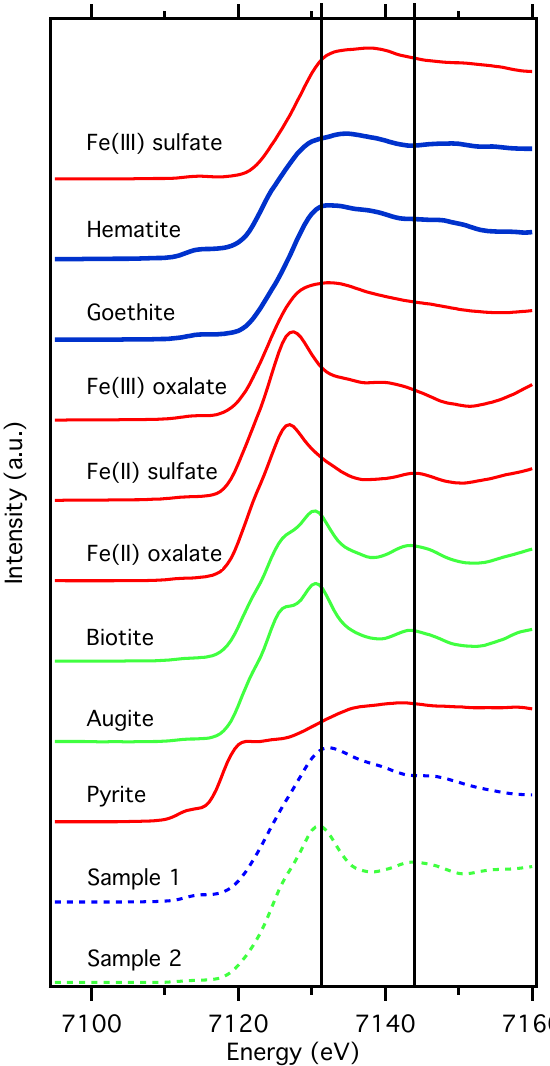
Fig. 4. Comparison of XANES sample spectra (dashed line) to the spectra of common Fe mineral standards (solid line). Two sample XANES spectra are plotted. Sample 1 (dashed blue line) repre- sents a typical Fe urban oxidized particle corresponding to the ma- jority of the data. Sample 2 (dashed green line) represents a reduced Fe particle observed in a few particles. Fe standards that resemble the ambient XANES sample spectra are plotted (iron oxide group (solid blue line) and iron-containing aluminosilicates (solid green line)). The vertical lines on the graph represent the energy where key XANES spectral features were identified.